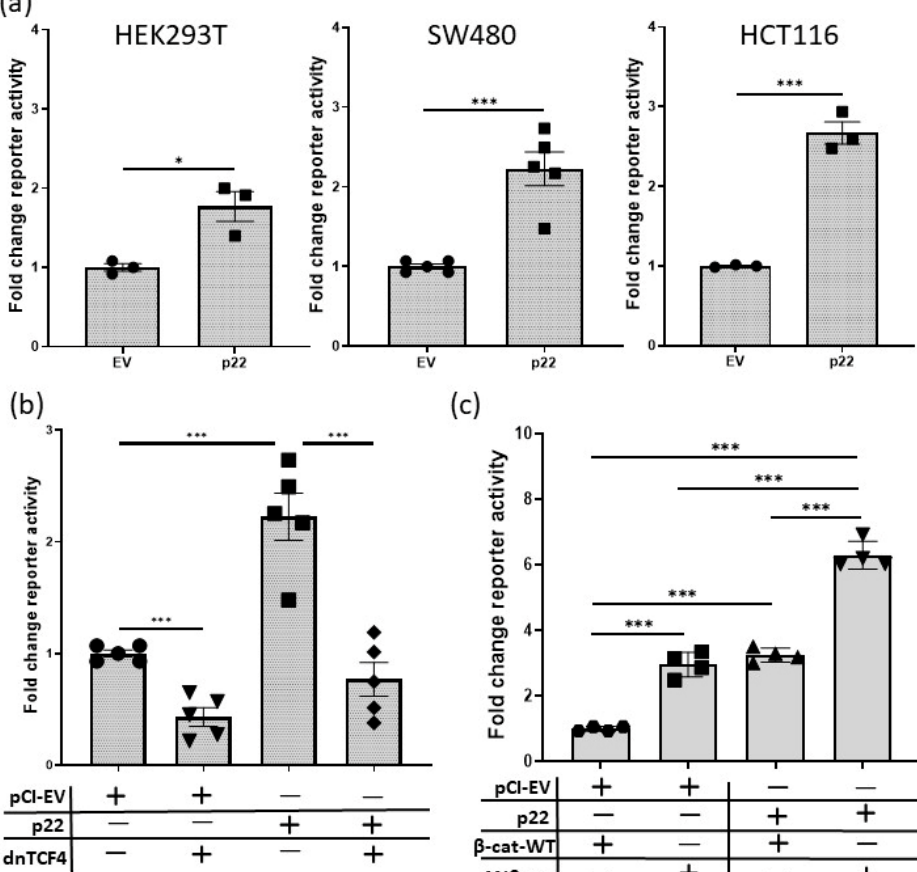
Figure 4. HBV p22 increases TCF/ β -catenin signaling in the context of oncogenic activation of the Wnt pathway. ( a ) Effect of 100 ng p22 expression plasmid on TCF/ β -catenin transcription activity pathway. ( a ) E ff ect of 100 ng p22 expression plasmid on TCF / β -catenin transcription activity